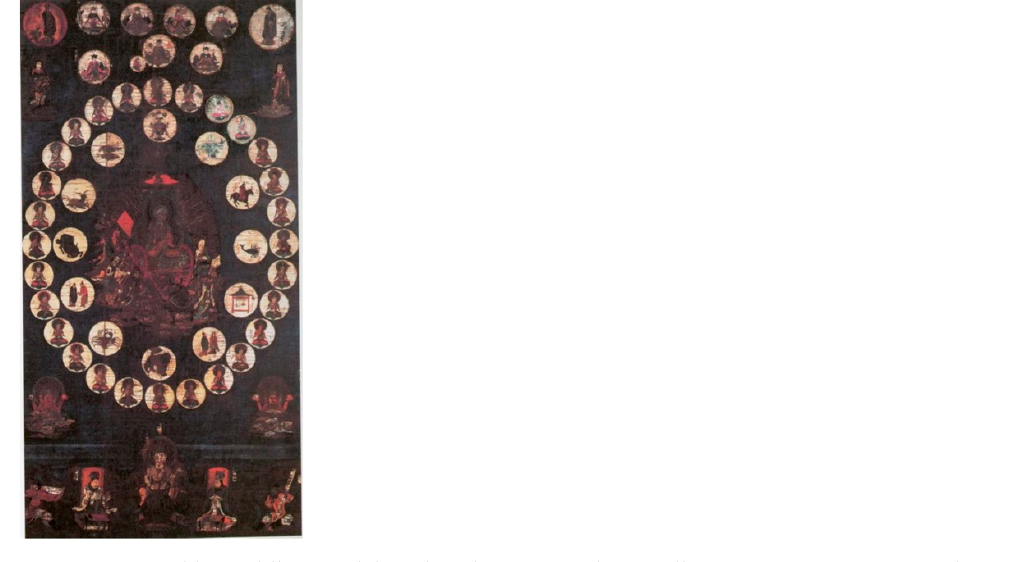
Figure 7. Tejaprabh¯a Buddha Mandala, Sakai-Shi, Japan, Color on Silk, 102.2 cm × 61.3 cm, Kamakura Jidai (13th–14th century).